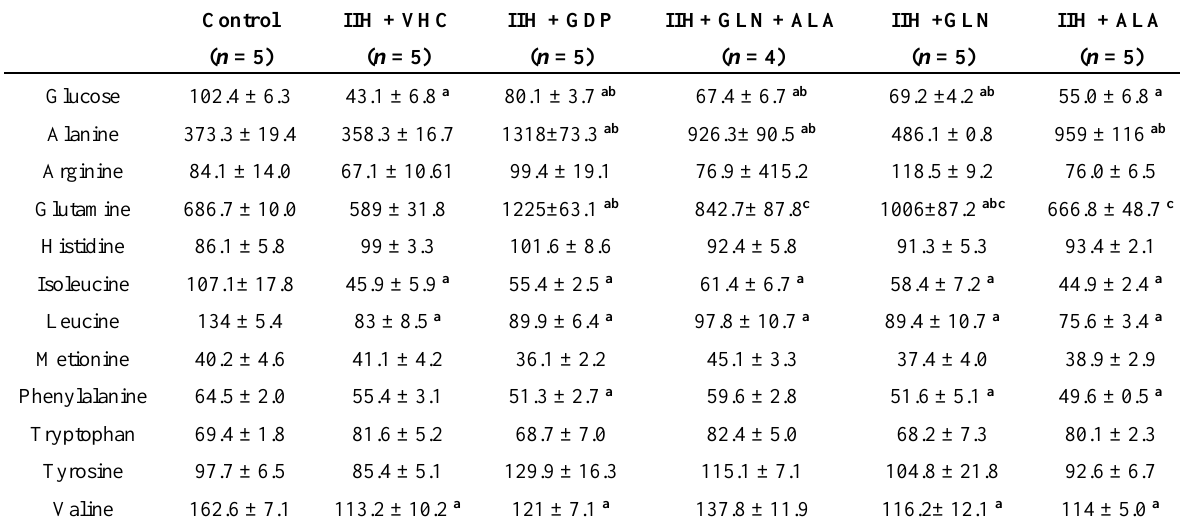
Table 5. Blood glucose (mg/dL) and amino acid (nmol/mL) levels 30 min after intraperitoneal insulin injection (IIH group). The IIH group was divided into 5 subgroups: IIH + oral vehicle (VHC), IIH + oral glutamine dipeptide (GDP), IIH + oral glutamine (GLN) + oral alanine (ALA), IIH + oral GLN or IIH + oral ALA. GDP (1000 mg/kg ) , GLN (619 mg/kg) + ALA (381 mg/kg), GLN (619 mg/kg) or ALA (381 mg/kg) or VHC was administered immediately after insulin injection. The Control group received intraperitoneal saline + oral VHC. Data expressed as means ± standard error were analyzed by ANOVA (Newman-Keuls post hoc test). a p < 0.05 vs. Control, b p < 0.05 vs. IIH + VHC and c p < 0.05 vs. IIH + oral